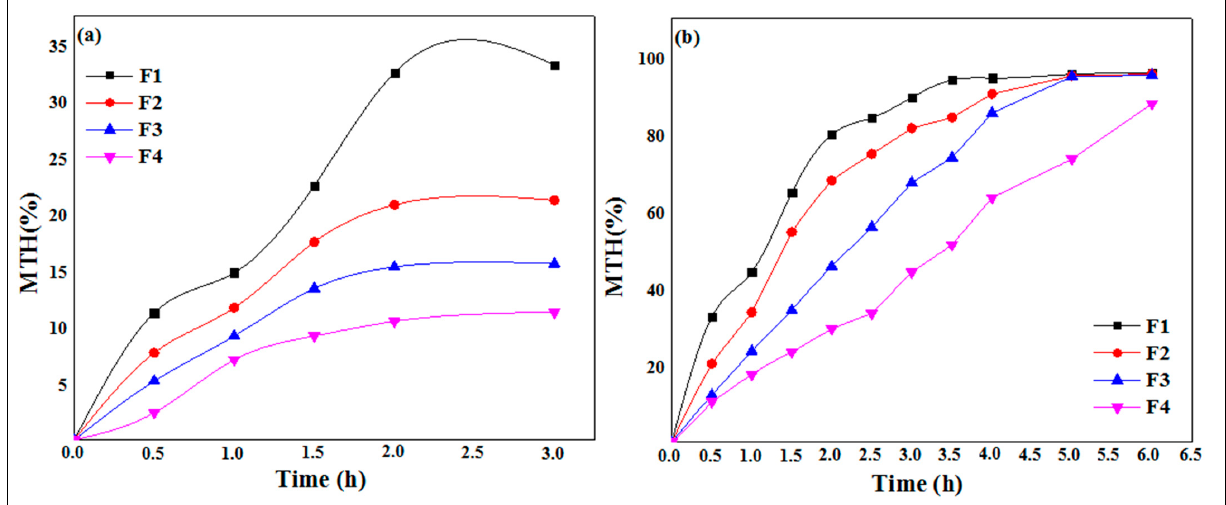
Figure 9. In vitro drug release of MTH from XG microspheres at pH 1.2 ( a ) and pH 6.8 ( b ). In the simulated gastric media pH 1.2 (Figure 9a), it is observed that the maximum release rates of MTH are greater in the F1 formulas (0.5 of XG %), with a value of 32.5% in 2.0 h, while this rate decreases when increasing the concentration of xanthan gum. Indeed, the release rates of metformin hydrochloride are, respectively, 20.8%, 15.3% and 10.5%, for F2 (0.75% of XG), F3 (1.0% of XG) and F4 (1.25% XG). These results indicate that with